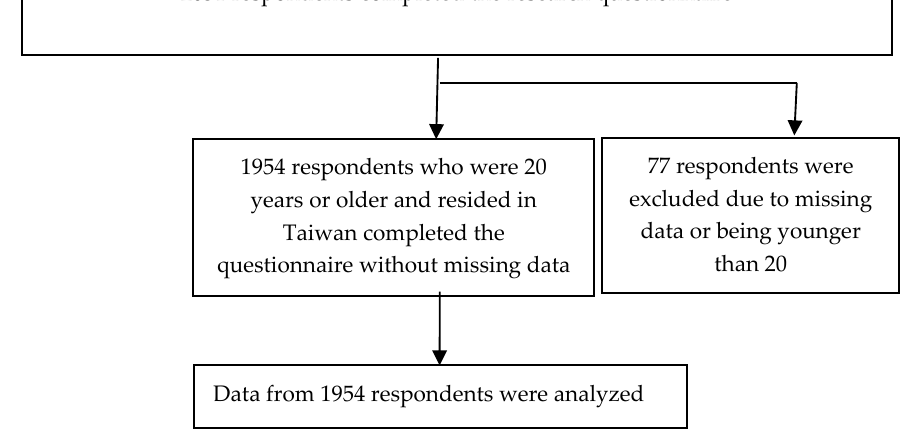
Figure 1. Flowchart of study design.